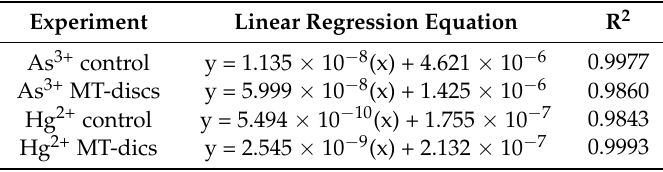
Figure 5. Representative ASV scans of MT-adsorbed paper discs with 25 μ L droplets of varying arsenic concentrations added. The concentrations are labeled above their respective traces. Inset in the top right is the linear response curve for the MT-disc set-up. Table 1. Equation of linear regressions for As 3+ and Hg 2+ determinations.